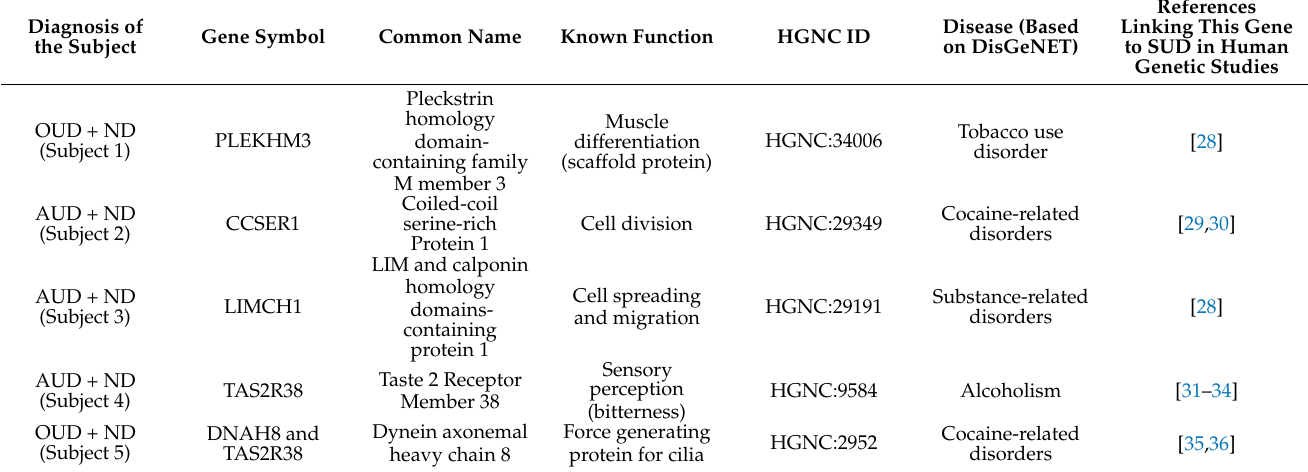
Table 3. Genes functionally disrupted in the five subjects and associated with SUD in previous studies; HGNC: Hugo Gene Nomenclature